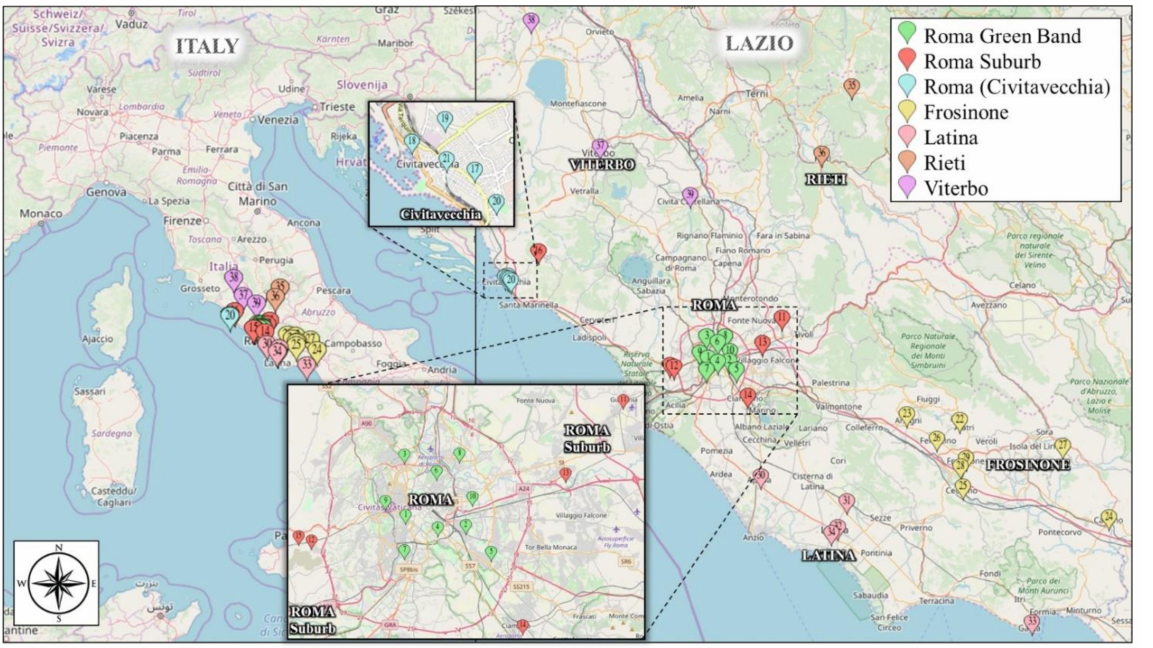
Figure 1. Monitoring stations network of ARPA LAZIO used in the present